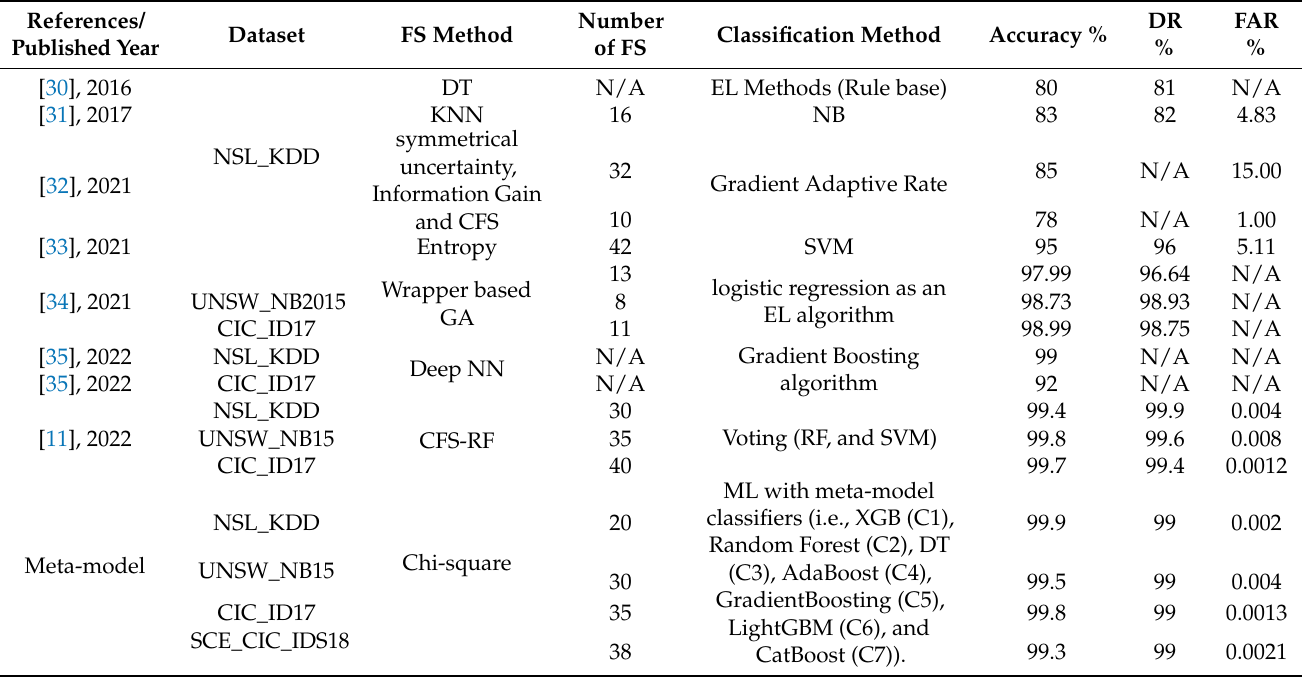
Table 3. Results comparison with other